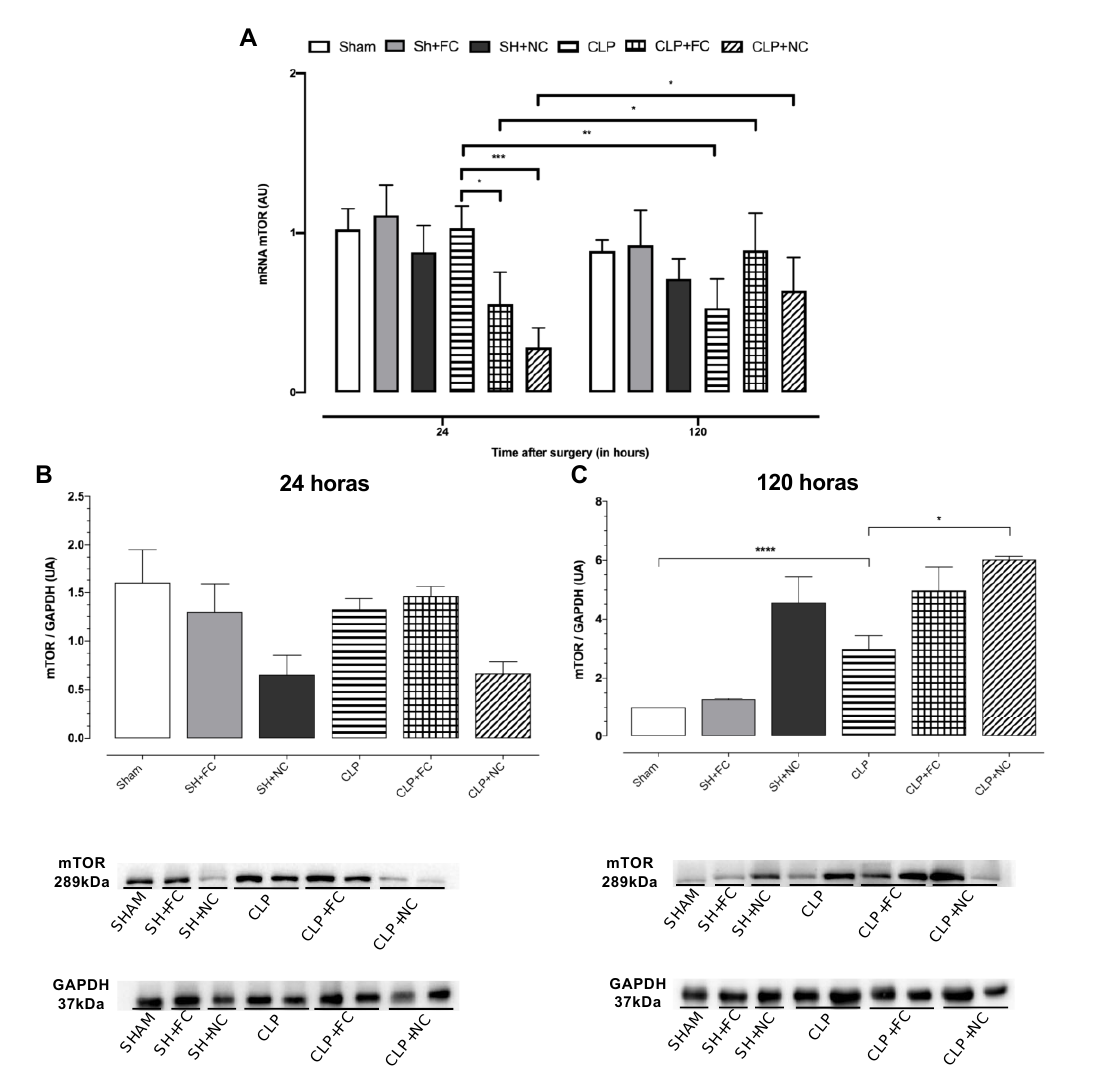
Figure 6. Analysis of gene expression profile by real-time PCR and protein by Western blotting of mTOR in the heart. ( A ) At 24 h there is no change in mTOR gene expression in the (CLP) group when compared to the control (SHAM); however, in the treated septic groups (CLP + FC and CLP + NC) ( p < 0.05 and p < 0.001, respectively), there was a significant reduction compared to (CLP). After 120 h of sepsis induction, there was a significant reduction in mTOR in the (CLP) group ( p < 0.01) compared to at 24 h; on the other hand, the treated groups (CLP + FC and CLP + NC) ( p < 0.05 and p < 0.05, respectively) increased. ( B ) No significant differences were found in the mTOR protein levels in the myocardium of the animals at 24 h. ( C ) At 120 h, there was a significant increase in the CLP group ( p < 0.0001) compared to the control (SHAM) in the CLP + NC group ( p < 0.05) in relation to the untreated septic group (CLP). At the bottom of ( B , C ), the autoradiograph resulting from western blot analysis of representative protein levels for mTOR and GAPDH of mouse hearts, subjected to sham operation (SHAM, SH + FC, and SH + NC) or sepsis induction (CLP, CLP + FC, and CLP + NC) 24 and 120 h after surgery. Results are expressed in arbitrary units (AU). p values * p < 0.05; ** p < 0.01; *** p < 0.001; **** p <